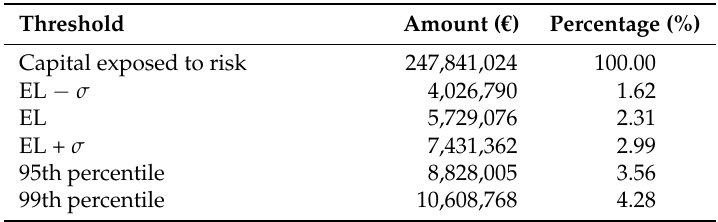
Figure 6. The figure illustrates the loss distribution for unactive loans at the pool cut-off date 2014H1 (Panel ( a )) and for active loans at the report date 2016H1 (Panel ( b )). We indicate in the figure loss distribution (black solid line), real loss portfolio loss (black dash-dot line), EL − σ (blue dotted line), EL (blue dash-dot line), EL + σ (thick blue dash-dot line), 99th percentile (red solid line) and 95th percentile (red dotted line). It is possible to calculate the real portfolio loss only on inactive loans, therefore this threshold is present only in Panel ( a ). Table 12. The table reports the capital exposed to risk and the thresholds for loss of the portfolio with active loans at the pool cut-off date of 2016H1. The capital exposed to risk is calculated as the sum of all the portfolio exposures net of recovery rates. The total net capital is 447 million Euro, with an expected loss (EL) of 5.72 million. The table reports the expected loss threshold (EL ± σ ), 95th and 99th percentile